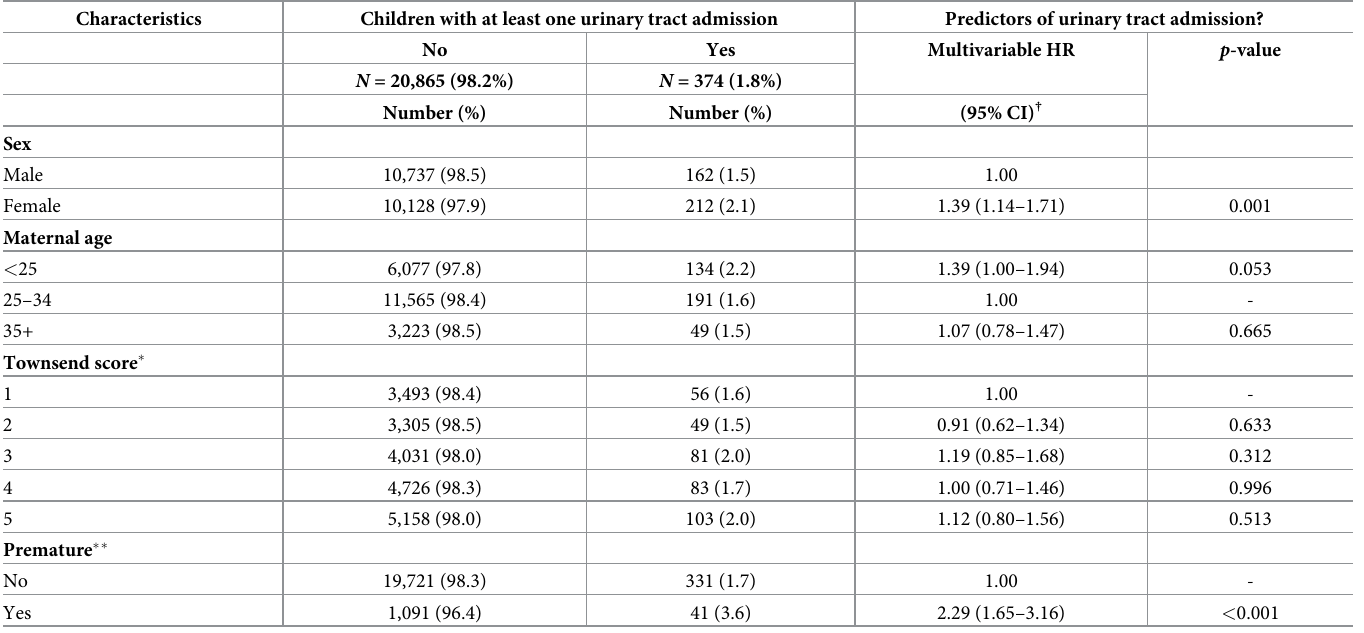
Table 2. Characteristics of the children according to whether they had at least one urinary tract admission during follow-up. Characteristics